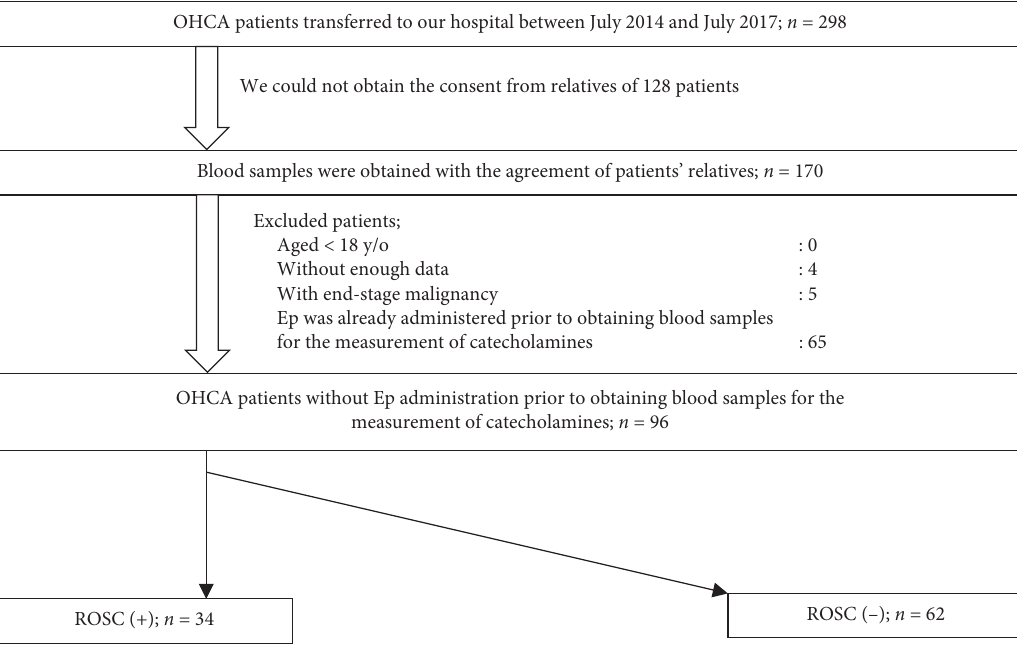
Figure 1: Study flow chart. Ep: epinephrine, OHCA: out-of-hospital cardiac arrest, and ROSC: return of spontaneous